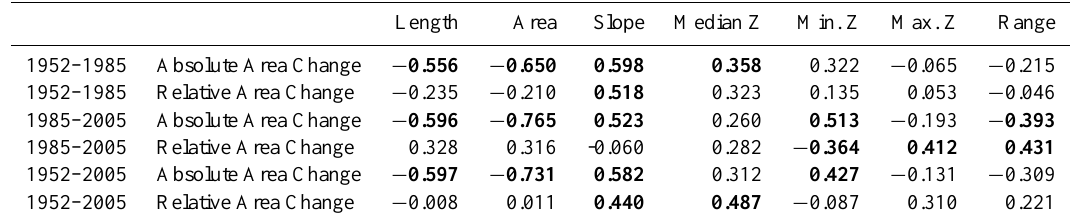
Table 5. Correlation table (Pearson-product moment) of relations of glacier area change with respect to glacier morphometry for three periods. Length Area Slope Median Z Min. Z Max. Z Range